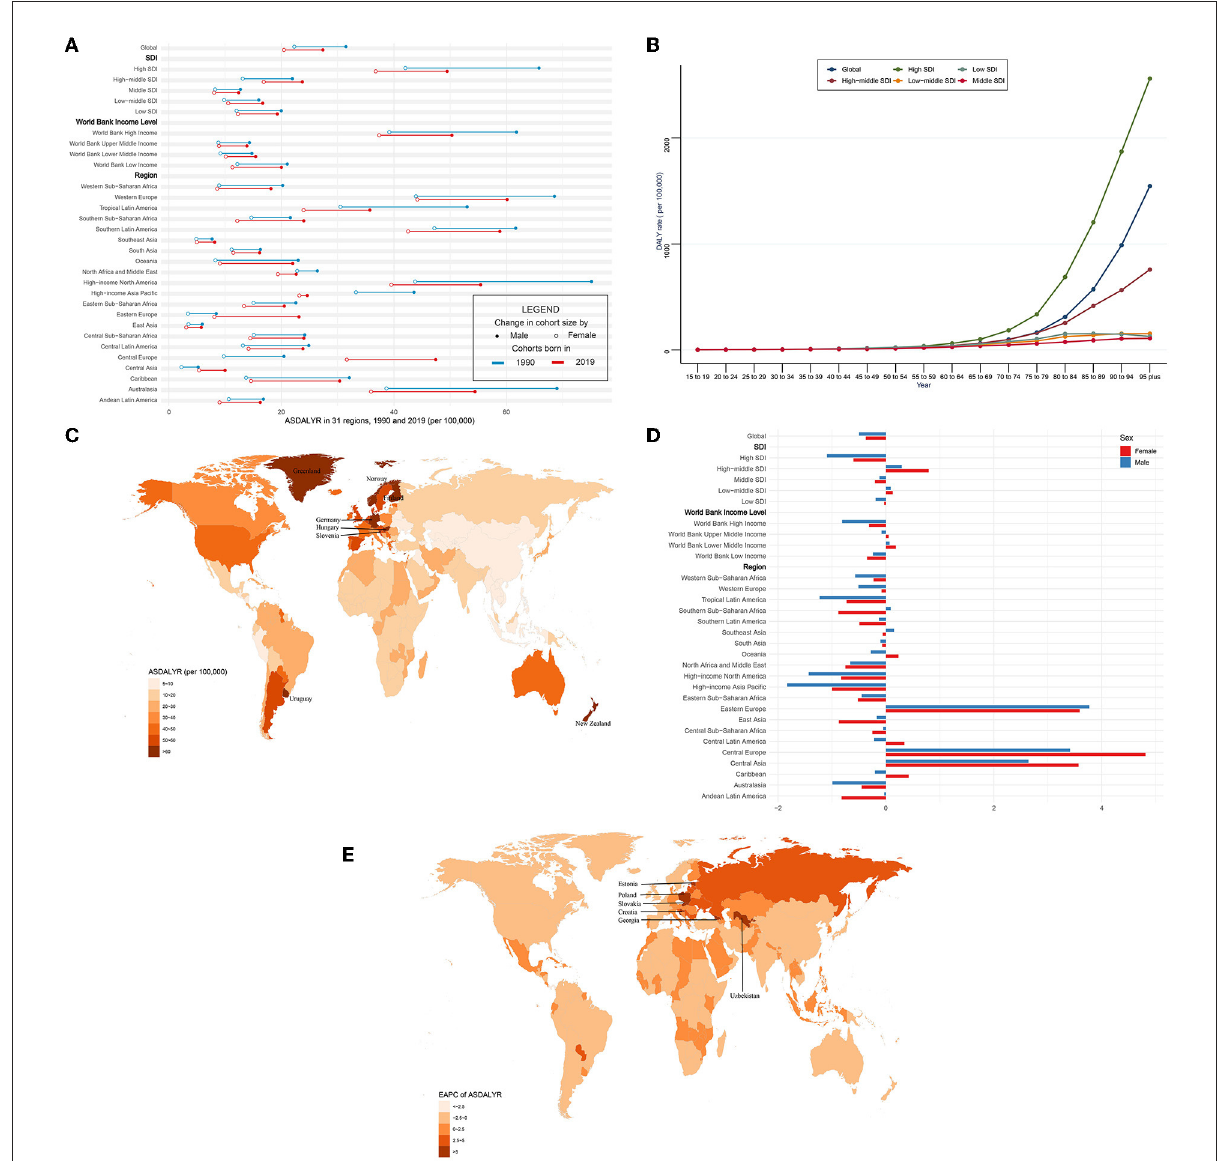
FIGURE4 ASDALYR and its trend of CAVD. (A) ASDALYR in 31 regions from 1990 to 2019. (B) DALY rate stratified by age in the globe and 5 SDI regions in 2019. (C) ASDALYR in 204 countries and territories in 2019. (D) EAPC of ASDALYR in 31 regions from 1990 to 2019. (E) EAPC of ASDALYR in 204 countries and territories from 1990 to 2019. CAVD, calcific aortic valve disease; ASDALYR, the age-standardized disability-adjusted life years rate; SDI, socio-demographic index; EAPC, estimated annual percentage